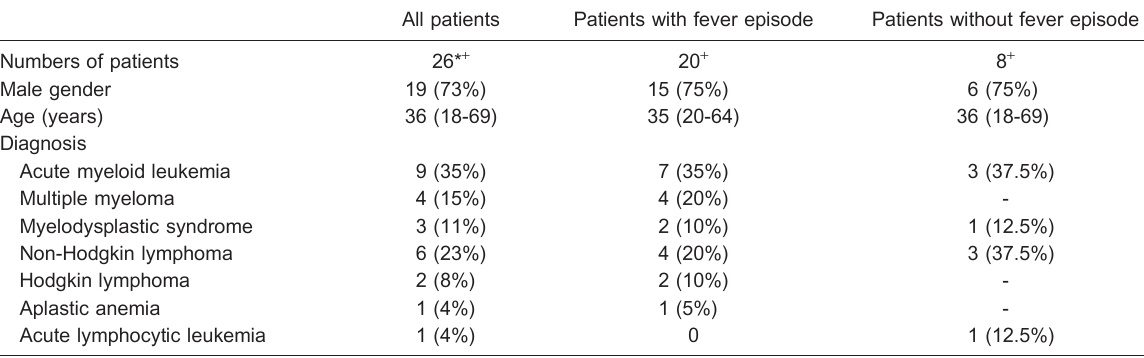
Table 1. Clinical characteristics of neutropenic patients presenting fever or not.